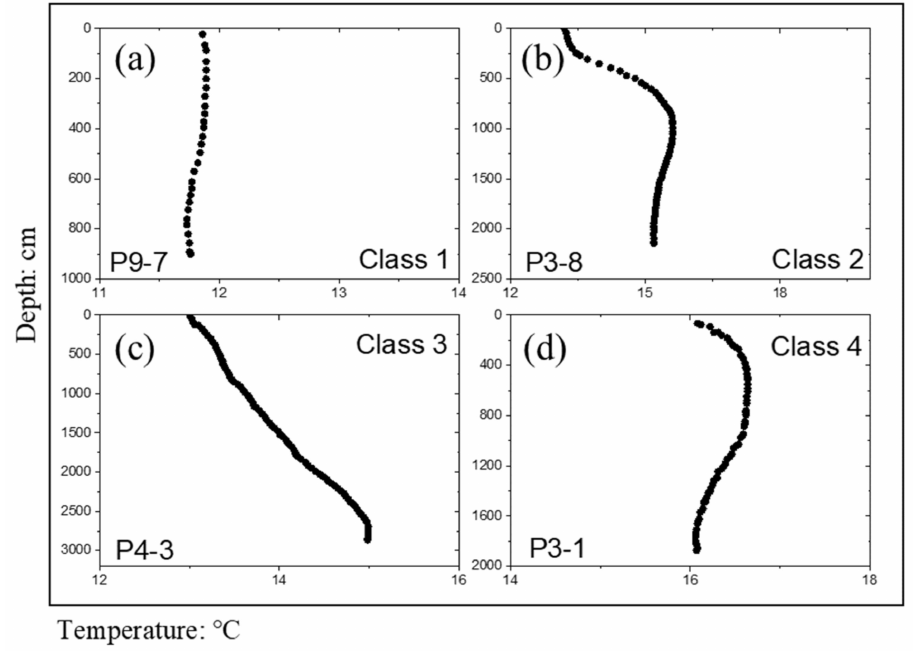
Figure 6. Representative temperature profiles of Classes 1, 2, 3, and 4 of the boreholes based on hydraulic behaviors. ( a – d ) represent the typical curves of Classes 1, 2, 3, and 4,